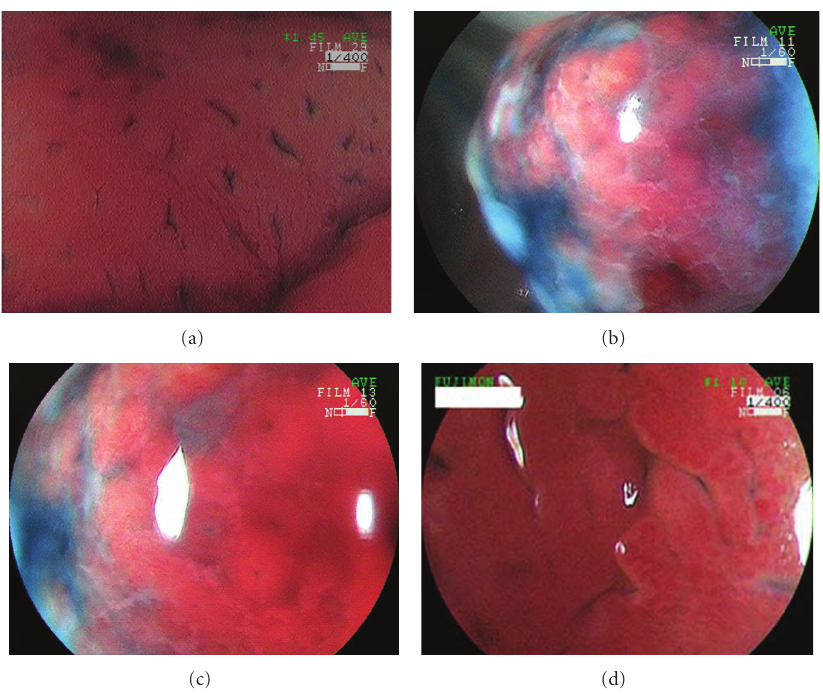
Figure 2: Magnifying colonoscopy appearance of three inflammatory myoglandular polyps. (a) In case 2, magnifying colonoscopy showed type I or II pit pattern. (b) In case 3, magnifying colonoscopy showed a red, slightly rugged surface consisting of an aggregation of smooth nodules. (c) Some normal round crypt openings were seen in the surface of the polyp by magnifying colonoscopy observation in case 3. (d) Magnifying colonoscopy showed a red, slightly rugged surface consisting of an aggregation of smooth nodules in case